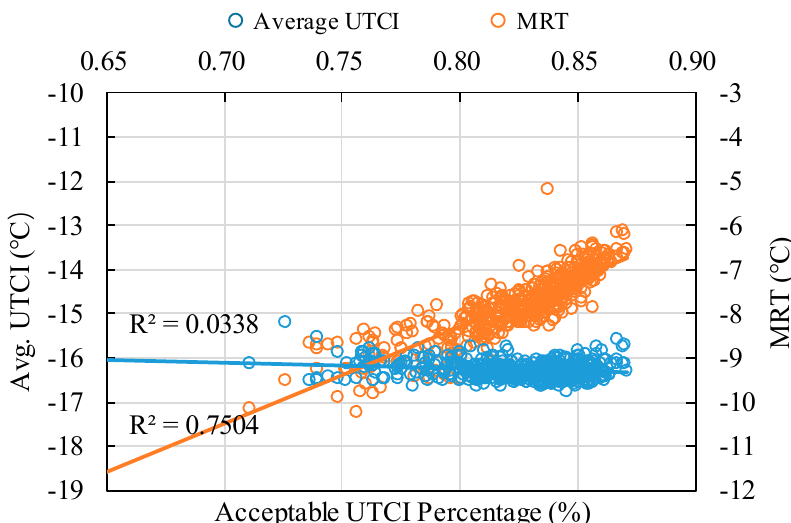
Figure 11. Correlation results of average UTCI, MRT, and acceptable UTCI percentage at block level.